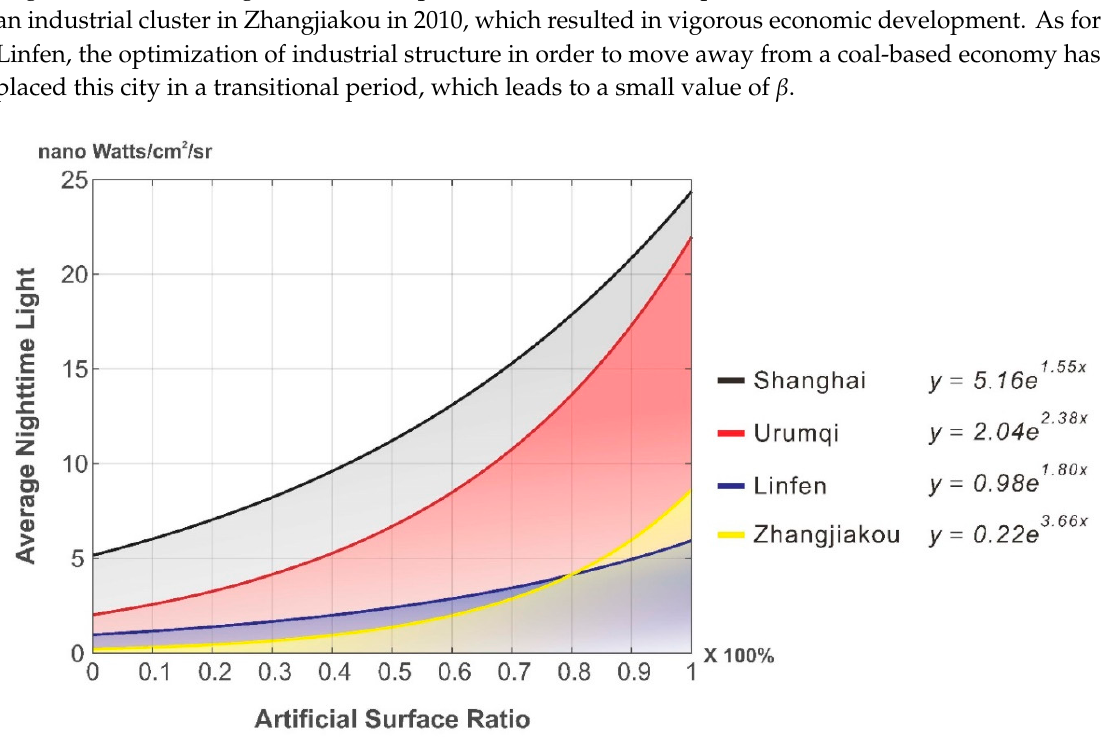
Figure 9. SSUDCs for four cities with significant differences in economy, size, and location (Shanghai, Urumqi, Linfen, and Zhangjiakou).